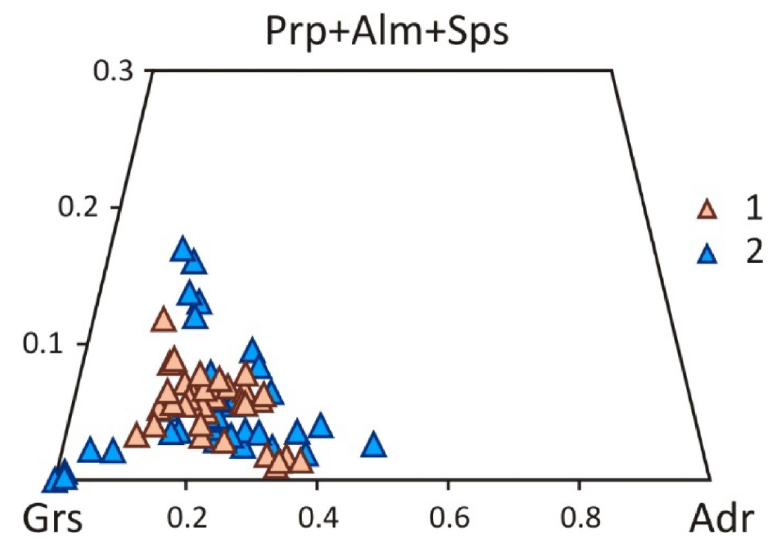
Figure 14. Garnets from skarned pyroxenite. 1 = garnets from pyroxenite fragment with remnant dolerite; 2 = garnets from other pyroxenite fragments.